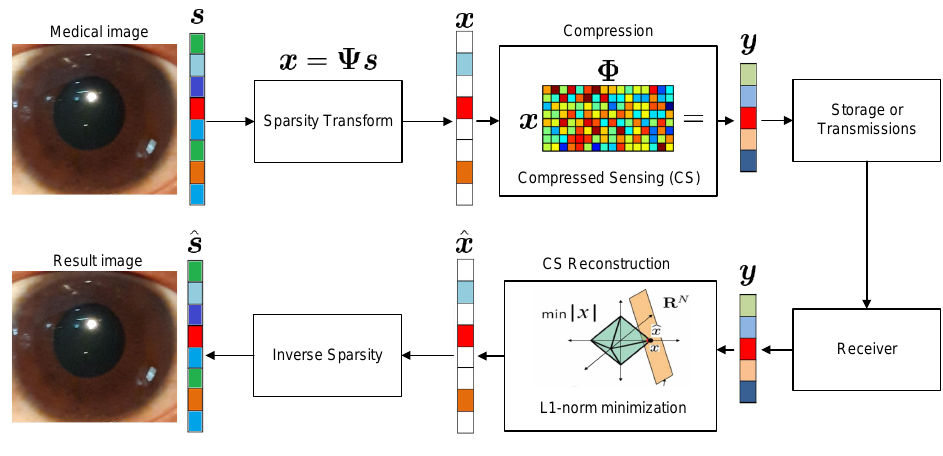
Figure 2. CS for medical image.